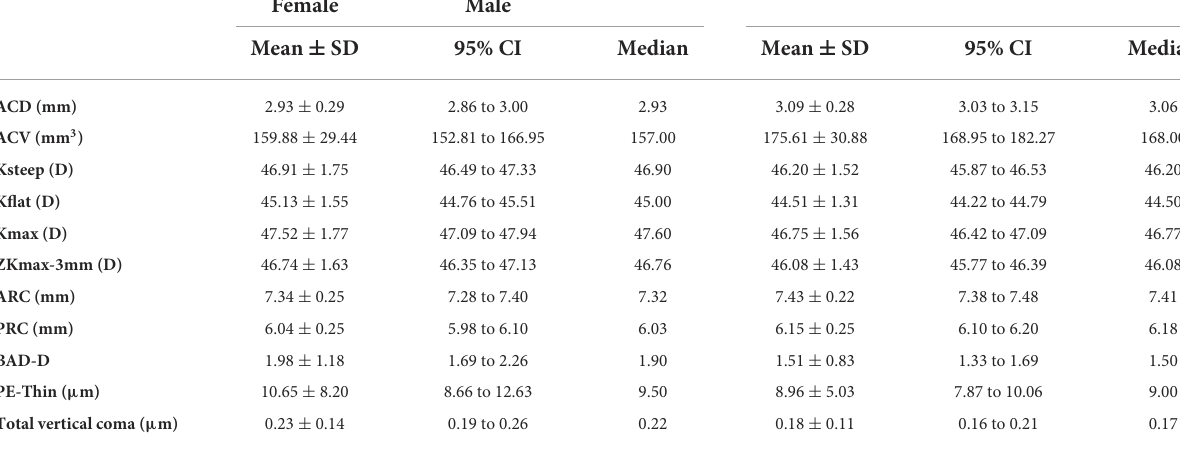
TABLE 2 Gender distribution of corneal indices in Down syndrome patients with normal cornea ( n =